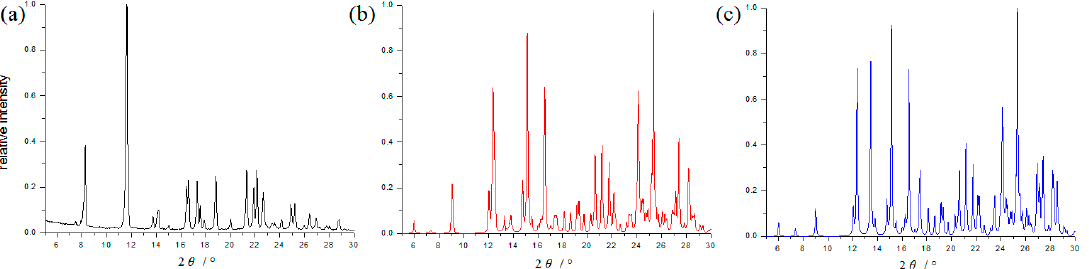
Figure 3. PXRD patterns of the pure APPP ( a ), the cocrystal ( b ) and simulated PXRD pattern of the cocrystal ( c ).